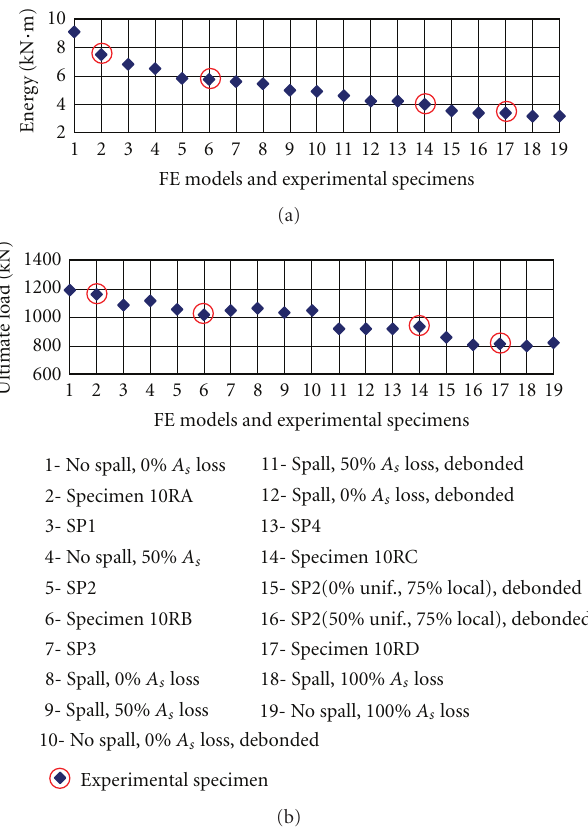
Figure 15: Summary results for maximum load and energy.